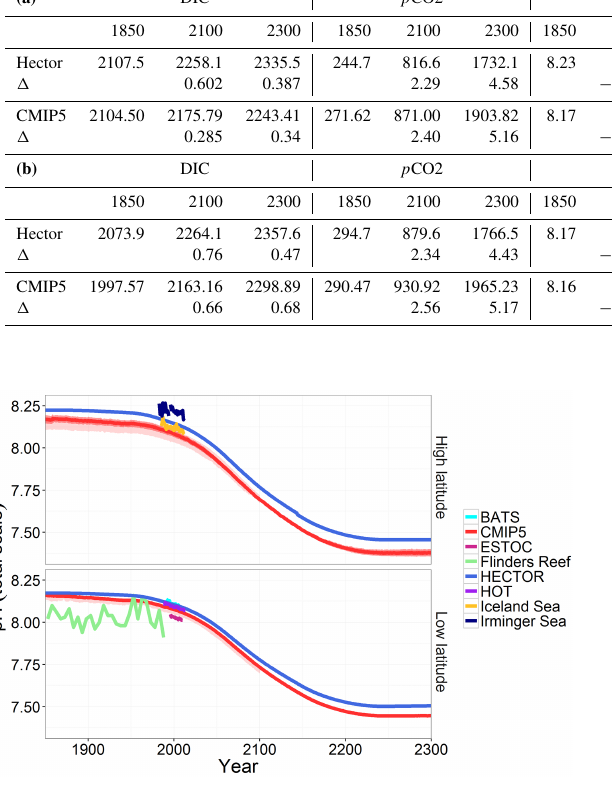
Figure 5. Aragonite saturation ( (cid:127) Ar ) for high- (top) and low- latitude (bottom) surface ocean under RCP 8.5: Hector (blue), CMIP5 median, standard deviation, and model range (red, n = 10 (1850–2100) and n = 2; 2101–2300), as well as observations from BATS (teal), HOT (purple), and Flinders Reef